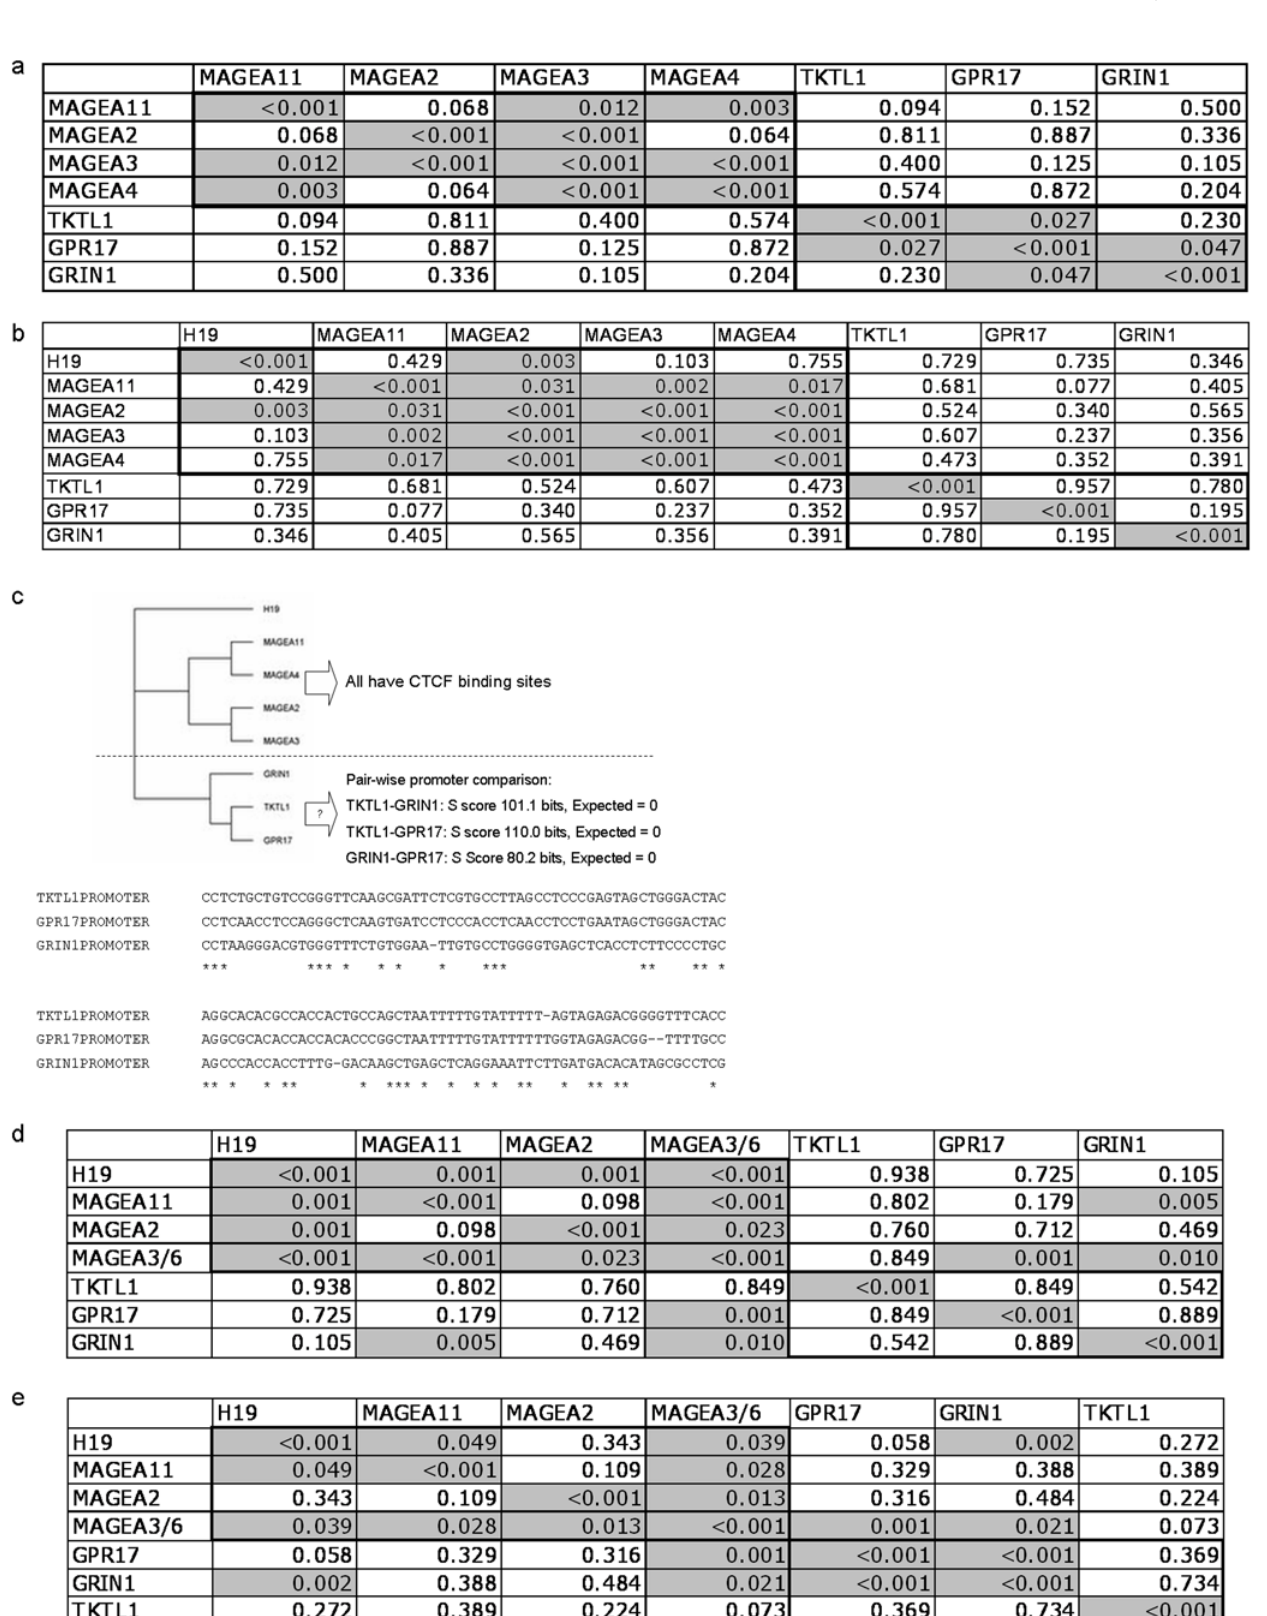
Figure 6. Gene expression and demethylation correlation. ( a ) Shows the gene expression correlation p-value matrix for the coexpression for each gene pair across all tumors. This comparison shows the correlation of each gene pair in 49 head and neck tumors. ( b ) Gene pair expression p- value correlation matrix for 80 NSCLC. Of note C19ORF28 is not tiled on this array platform. ( c ) Analysis of promoter regions for the genes. Shown is a